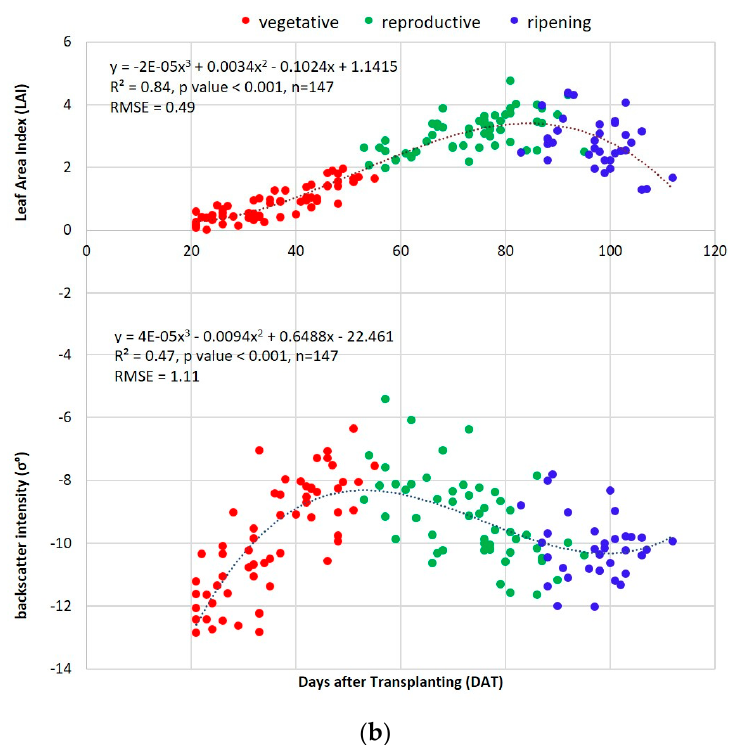
Figure 6. ( a ) The relationship of backscatter intensity ( σ °) with LAI for the vegetative (seedling–tillering) and reproductive phase (panicle initiation–booting to heading–flowering). The black line is the fitted regression line and each data point is represented by a different colour depicting the growth phase at the time of field observation . ( b ) The relationship of LAI (top scatter plot) and X-band backscattering coefficient (bottom) with days after transplanting (DAT) that covers transplanting to ripening phase.